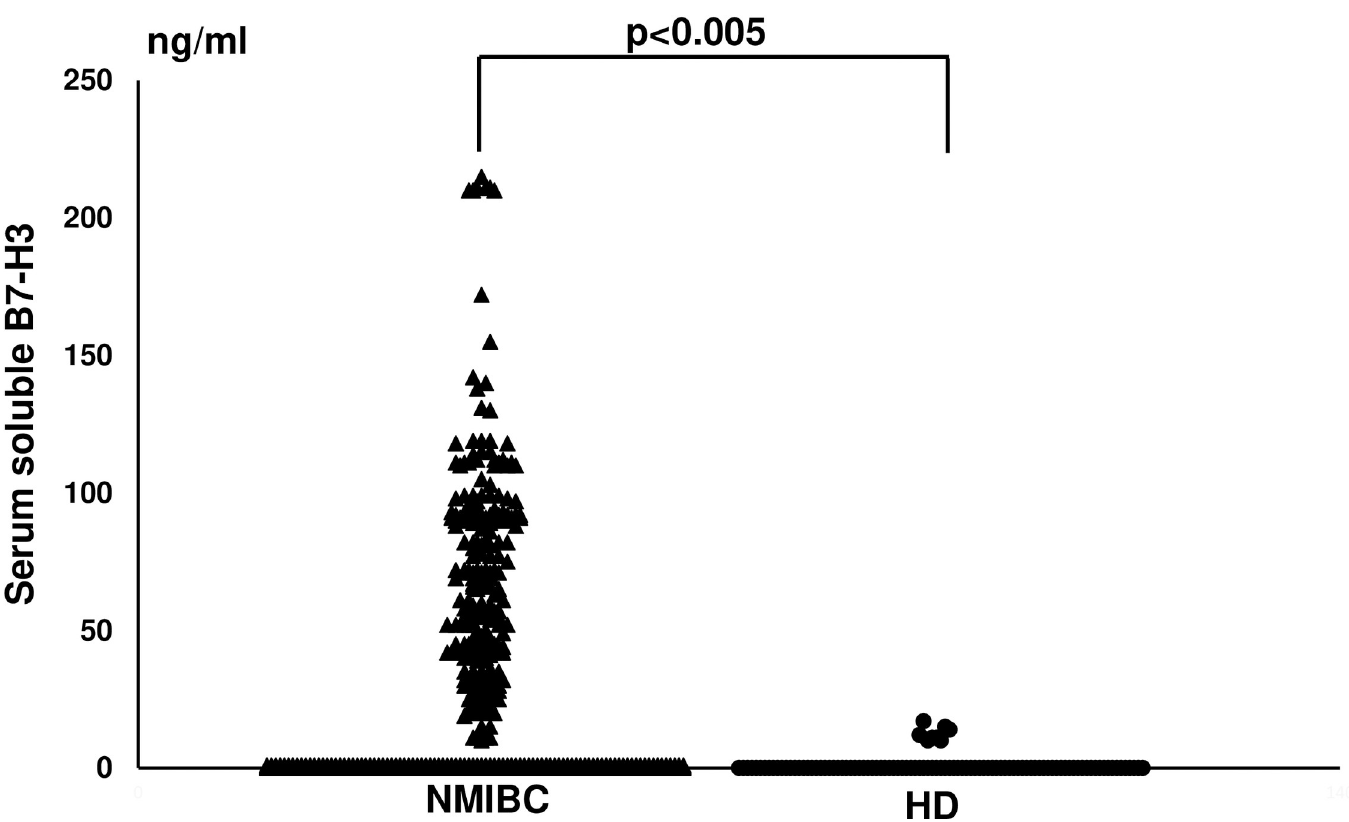
Fig 1. Detection of serum soluble B7-H3 (sB7-H3) in patients with non-muscle invasive bladder cancer (NMIBC). We next examined the concentration of sB7-H3 in the HD and patients with NMIBC. Sera from 555 patients with NMIBC and 103 HD were diluted to 1:10 in PBS and tested by ELISA as described in Materials and Methods. The data were analyzed using the Mann-Whitney U test followed by multiple regression analysis (p < 0.005).